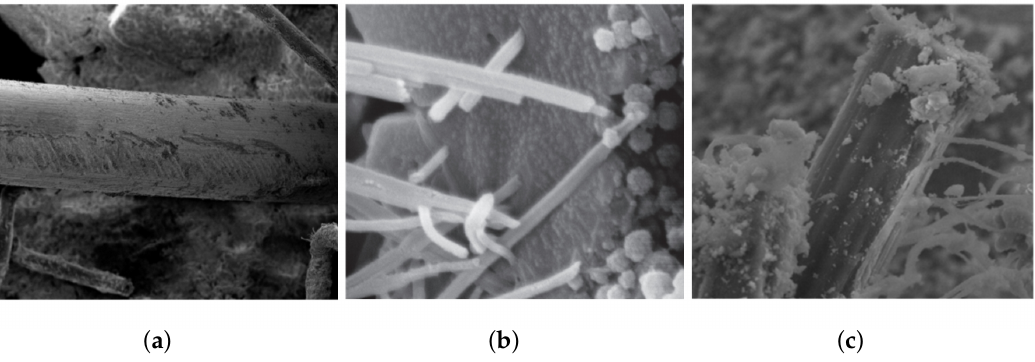
Figure 9. SEM photo of PP, PVA and steel fiber in UHP-HFRC material. ( a ) Steel fiber in matrix [12]; ( b ) PP fiber in matrix [10]; ( c ) PVA fiber in matrix